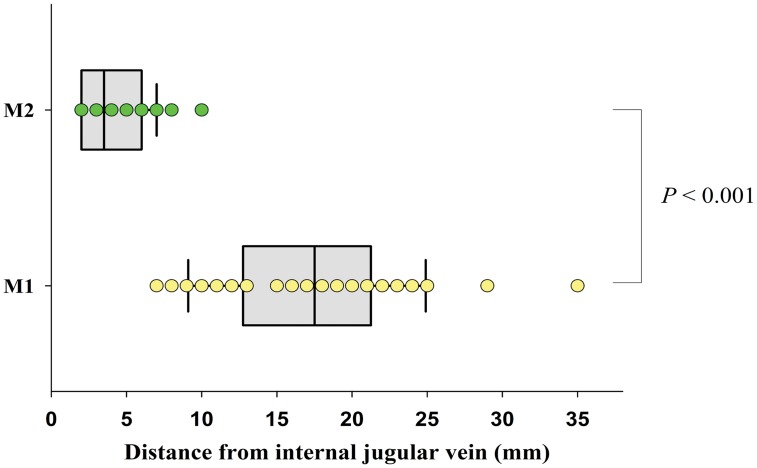
Comparison of distances between M1 and M2 from the ultrasound-identified IJV.Individual and median (interquartile range) distances between M1 and M2 from the ultrasound-identified IJV. For effective representation of the distance, the axes were inverted. The line in the middle box represents the median value and the lateral borders of the box represent interquartile ranges. Individual values are represented as dots (yellow dots in M1 and green dots in M2). M1, the central landmark; M2, the alternative landmark; IJV, internal jugular vein.